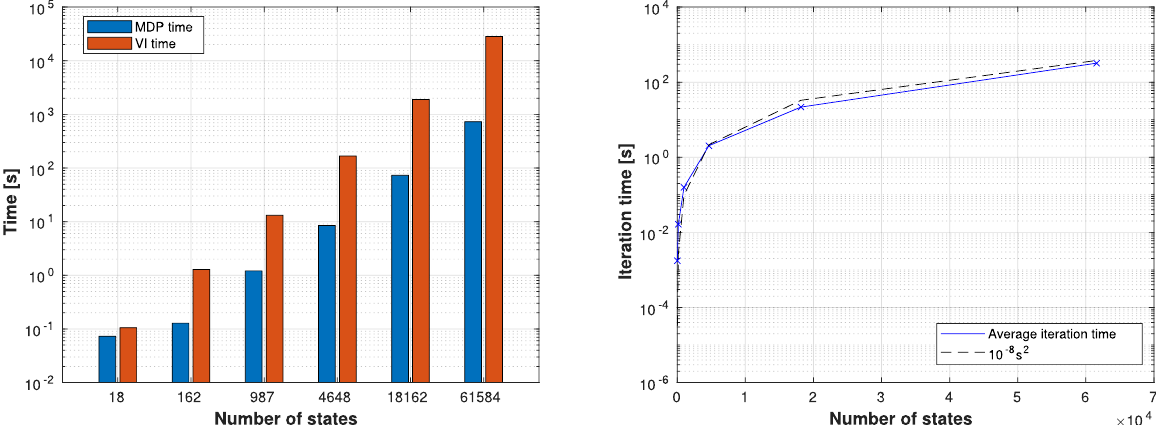
Figure 10. ( Left ) MDP conversion time and value iteration convergence time as the state space grows; ( Right ) Average time that each iteration takes when performing value iteration, where s represents the number of